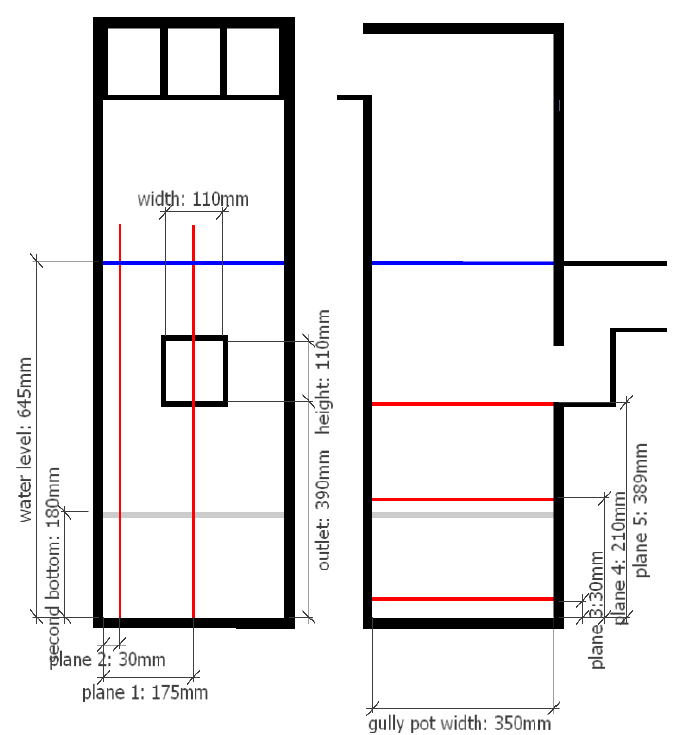
Figure 5. Side and front view of the planes of interest (in red) in the gully pot. The blue line indicates the water level, the grey line the second bottom.